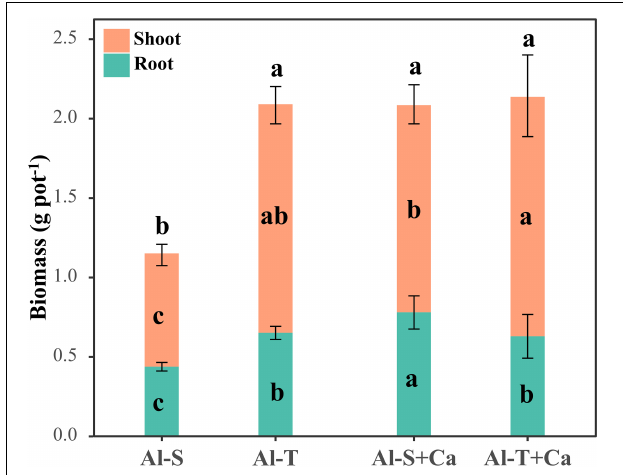
FIGURE 1 | Rice shoot and root biomasses. Different lowercase letters within the bottom, middle, and top parts of columns indicate significant differences in root, shoot, and total biomasses among treatments, respectively ( P < 0.05). Al-S, Al-sensitive rice; Al-T, Al-tolerant rice; Al-S + Ca, Al-sensitive rice and CaCO 3 ; Al-T + Ca, Al-tolerant rice and CaCO 3 .